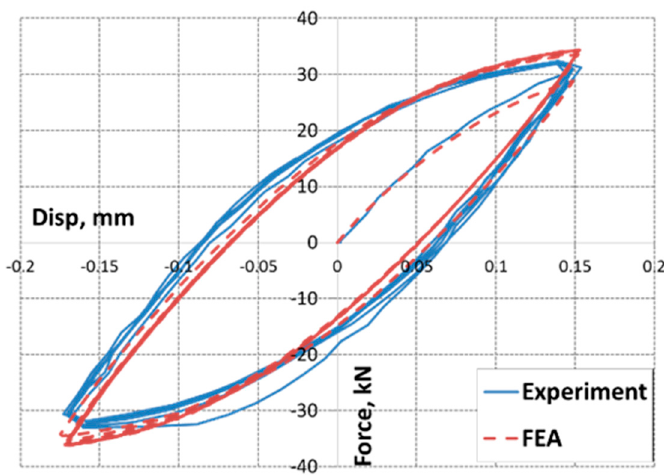
Figure 1. Strain-controlled hysteresis loops of “R0”. The PPL plasticity model by Bai and Wierzbicki along with the combined hardening rule shows an excellent correlation between the experiment and numerical force–displacement curves. Reproduced from Reference [1], with permission from Elsevier, 2019.